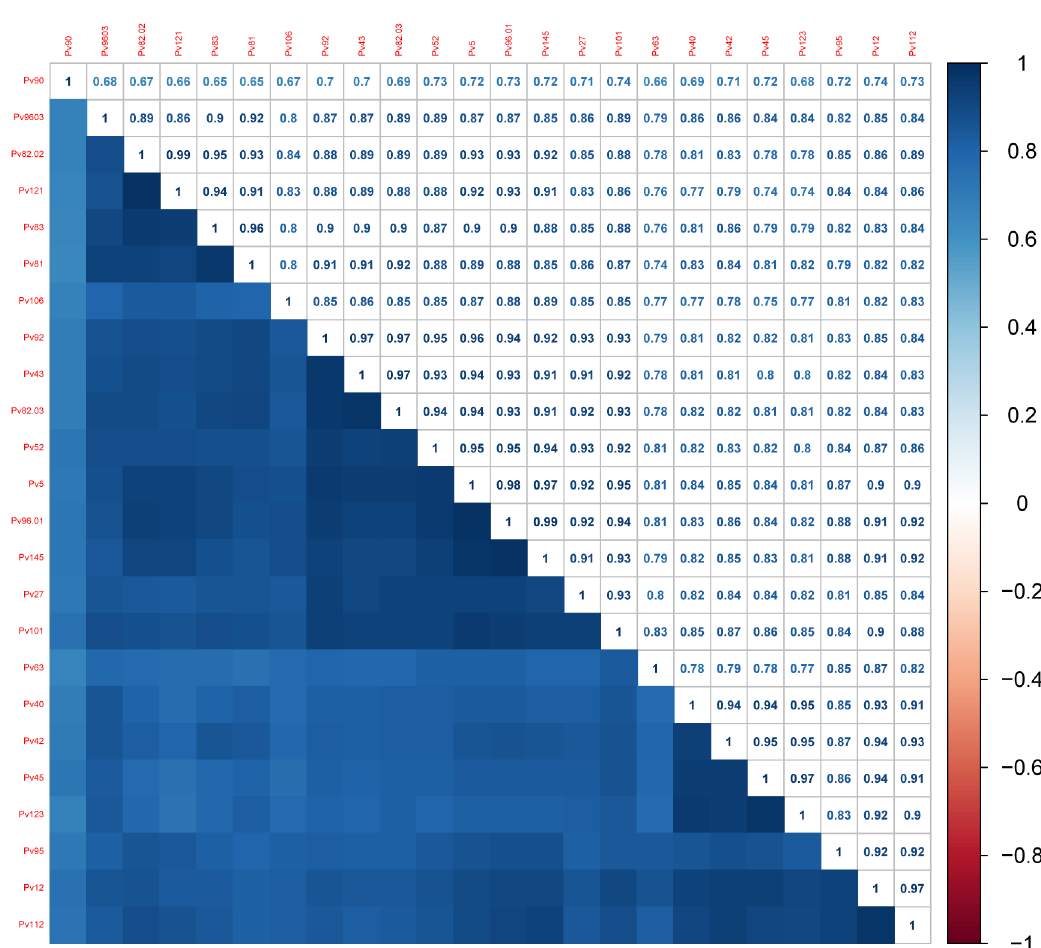
Fig 2. Heat map representation of correlation of antibody response between coiled coil antigens. The heat map colors correspond to correlationsgradingfrom -1 (negativecorrelation, red), no correlation(white) to 1 (positive